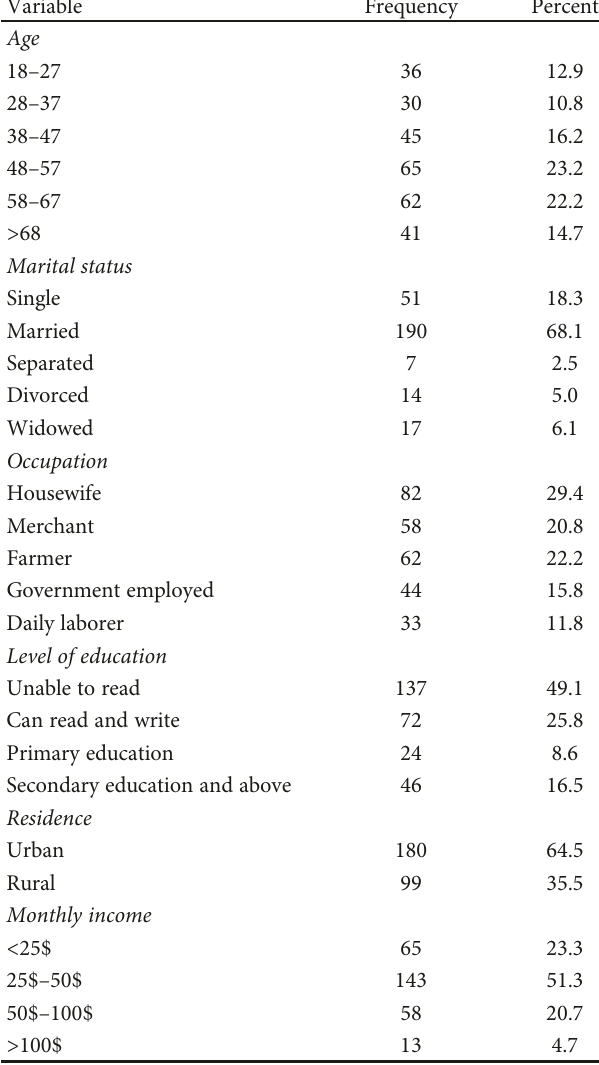
Table 1: Sociodemographic characteristics of respondents in Gondar University Referral Hospital, Northwest, Ethiopia